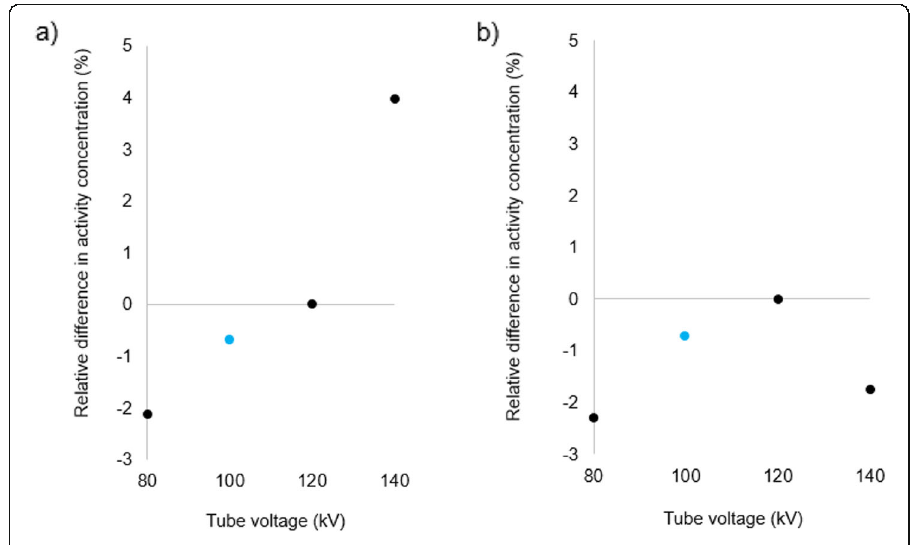
automatically selecting the most optimal tube voltage for the individual patient. When CARE kV is on, it automatically chooses the optimal kV for that patient and scan range, determined by the kV and resulting mAs delivering the lowest dose whilst pro- viding the reference image quality. Therefore, the CARE kV on setting should not cause an increase in dose, compared with the standard 120-kV setting. However, it could be that for a given patient and scan range 120 kV is the optimal tube voltage. In this case, the dose would not change compared with that of a 120 kV scan in CARE kV ‘ semi ’ mode. However, it is still an advantage to use CARE kV, since the dose saving will still be optimised for the scan type, which in this investigation was set to non-contrast- enhanced CT.